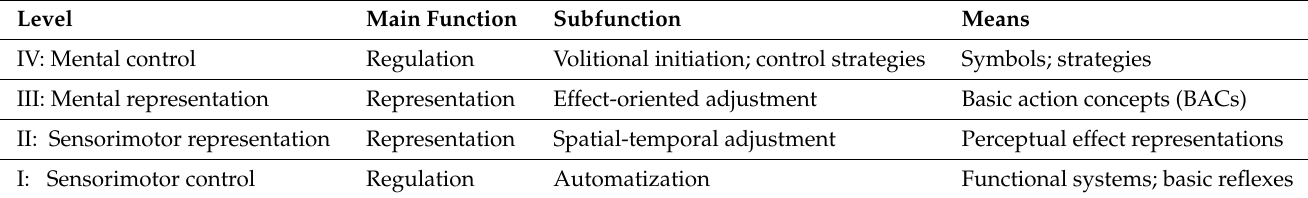
Table 1. Levels of action organization (modified from [12], p.